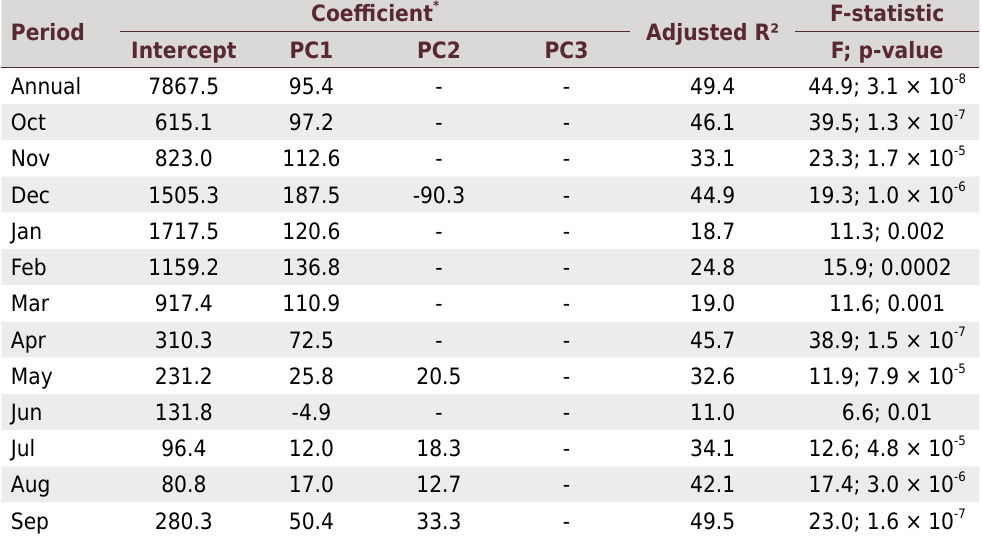
Table 2. Results of multiple linear regression (intercept and coefficients) between rainfall erosivity and principal components